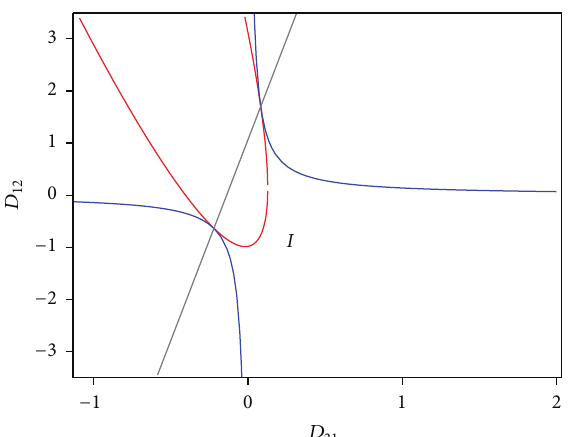
Figure 1: Bifurcation diagram with 𝐷 12 and 𝐷 21 , where the parameters values are taken as 𝐾 = 0.205 , 𝑢 1 = 0.7 , 𝑟 1 = 0.2 , 𝑢 2 = 0.382 , 𝛽 1 = 0.21 , = 0.2428 , 𝛽 = 0.1 , V = 0.09 , V = 0.013 , 𝐷 = 0.04 , and 𝐷 = 3.5 . The gray line represents 𝐷 𝑎 + 𝐷 𝑎 − 𝐷 𝑎 − 𝐷 𝑎 = 0 , 𝛽 2 3 1 2 11 22 11 22 22 11 12 21 21 12 ) = 0 , and the red curve represents 𝐷 𝑎 + 𝐷 𝑎 − 𝐷 𝑎 − 𝐷 𝑎 − 2√ det (𝐷) det (𝐽 ) = 0 ; the blue curve represents det (𝐷) det (𝐽 𝐸 11 22 22 11 12 21 21 12 𝐸 𝑒1 𝑒1 thus 𝐼 shows the zone where the instability induced by diffusion occurs. The remainder of this paper is organized as follows. In Section 2, we describe and analyze the toxin-phytoplankton-zooplankton system, and we derive the criteria for the stability and instability of a system with cross-diffusion. In Section 3, we present the results of numerical simulations and discuss their implications. Finally, we give our conclusions in Section 4.